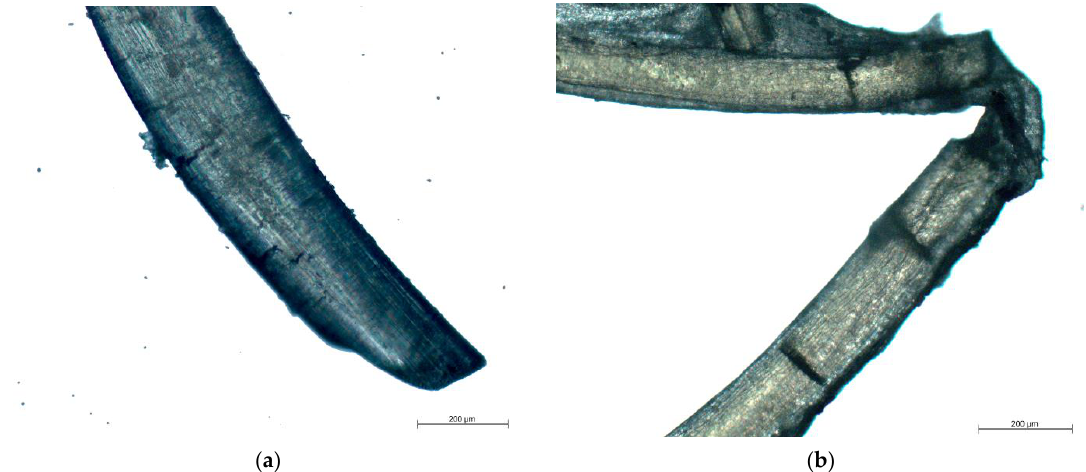
Figure 6. Images of the chitosan fiber (0.5% ChNF) located under m. latissimus dorsi that underwent bioresorption for ( a ) 14 days and ( b ) 91 days.